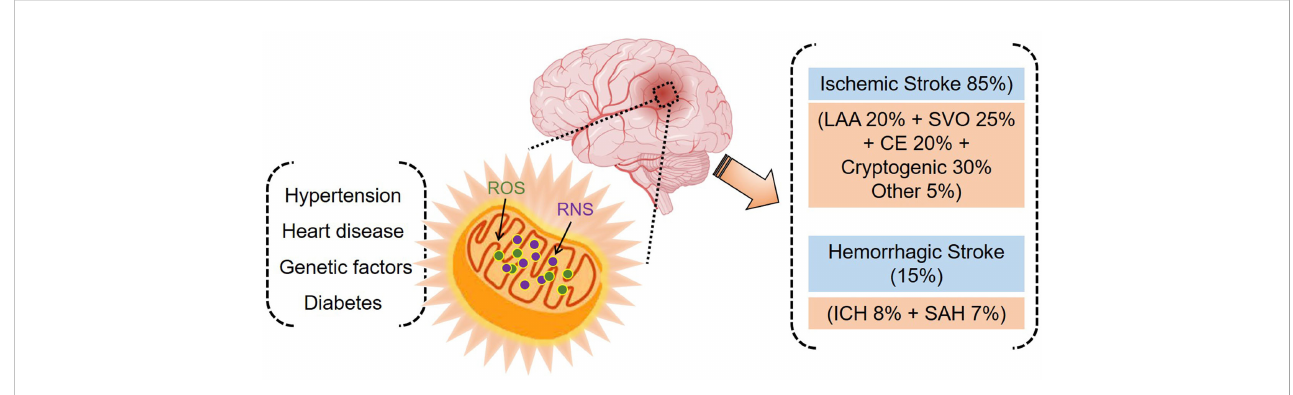
FIGURE 1 Stroke and associated risk factors. Oxidative stress plays a central role in stroke pathogenesis (ischemic and hemorrhagic) and is implicated in hypertension, heart disease, genetic factors, and